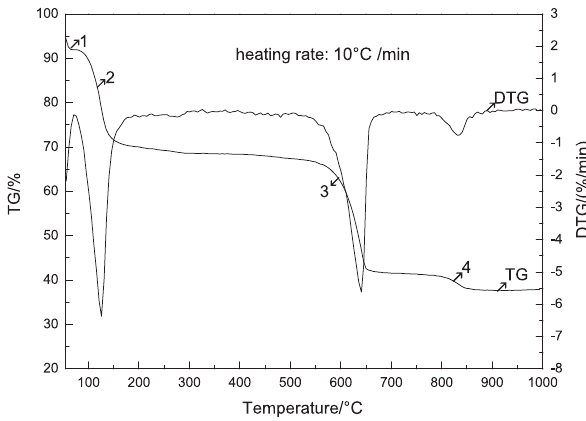
Fig. 2: TG/DTG curves of industrial ferrous sulfate in air.